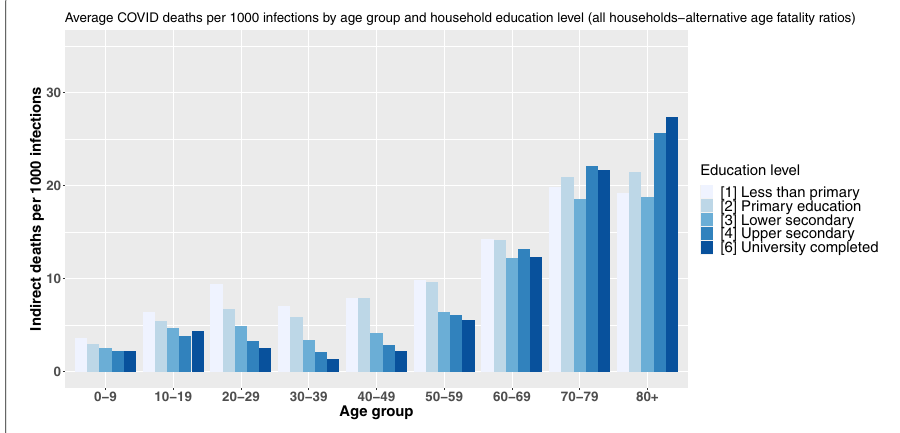
Fig. 15 Average COVID-19 deaths per 1000 infections by age group and head-of-household education level (fatality ratios from Verity et al.)